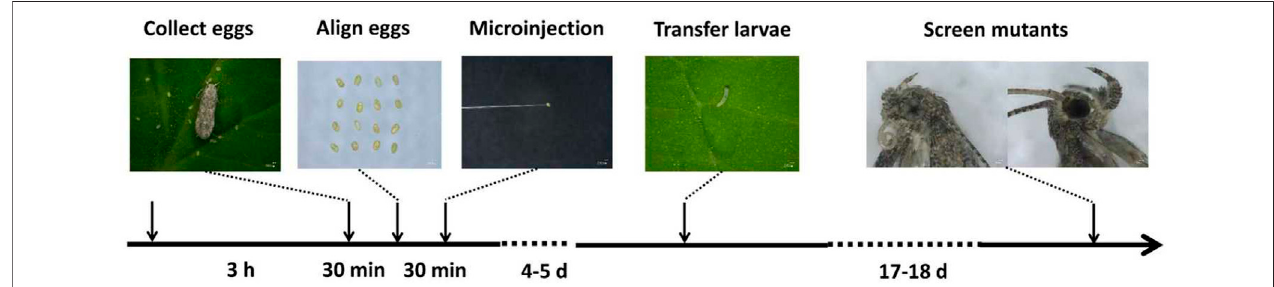
FIGURE 7 | CRISPR/Cas9 work fl ow for the Tuta absoluta . Five stages: (1) adults laid eggs and collected all the eggs (within 3 h), (2) careful lined up the eggs on double-sided adhesive tape (with 30 min), (3) microinjection of embryos with a mixture of Cas9 protein and sgRNAs and placing back of injected embryos under rearing conditions (within 30 min), (4) careful transfer of newly hatched larvae on fresh tomato leaves (within 4 – 5 days) and (5) screening for the eye mutants after adult emergence (within 17 – 18